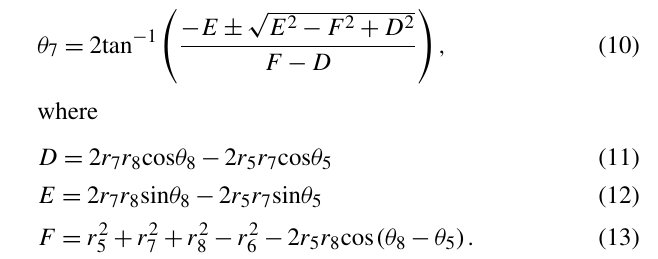
angle between vector r i and the x